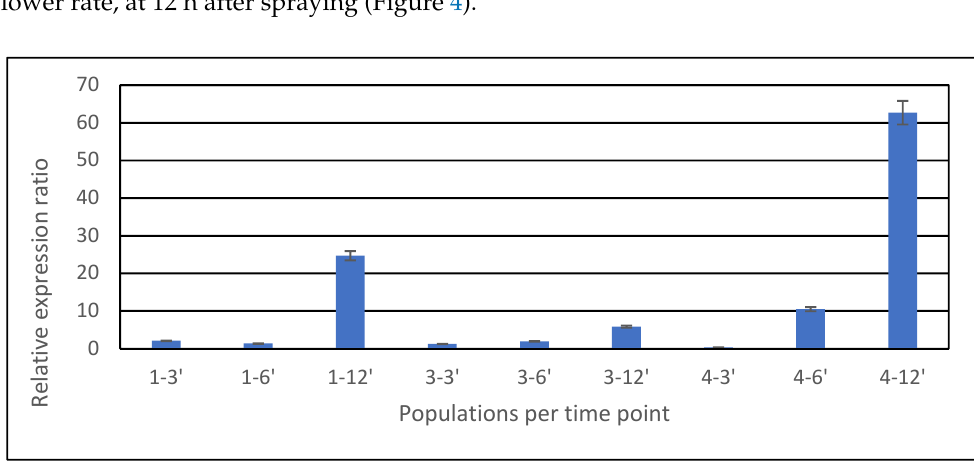
Figure 4. Relative expression ratio of the ABC III gene for the populations 1, 3 and 4 in glyphosate- applied leaves (3, 6, 12 h after glyphosate